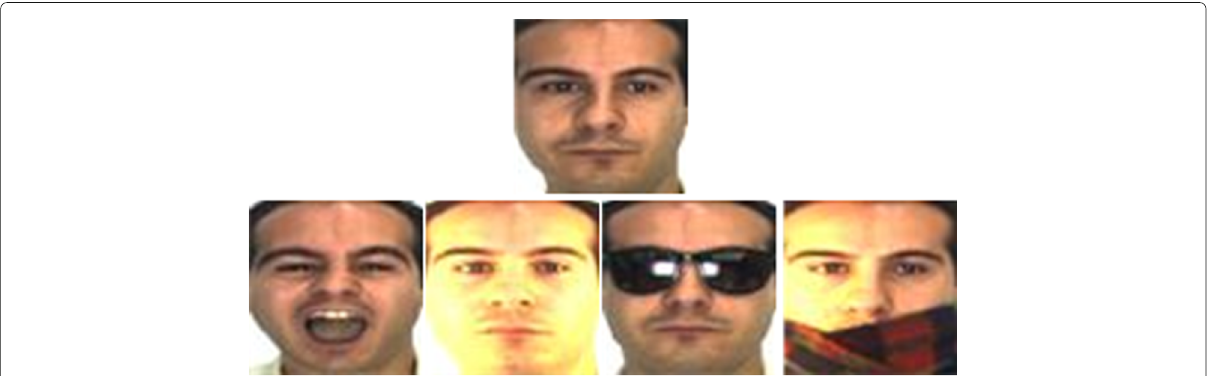
Fig. 6 Sample image of AR database: The first line of the figure is the image of the natural expression; the second line is the test image, representing four situations from left to right: facial expression, light, occlusion, and light + occlusion